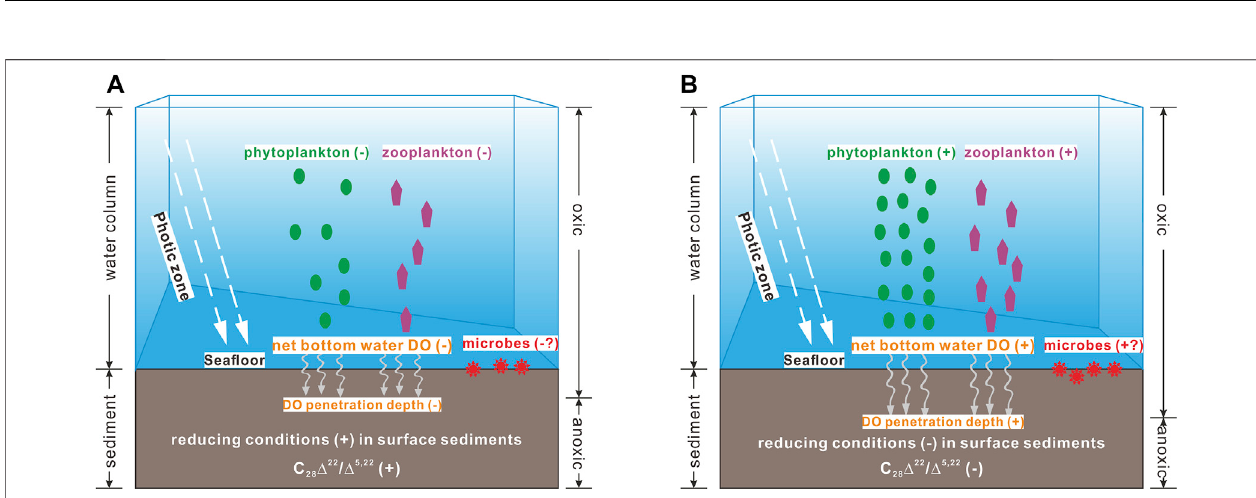
FIGURE9| SchematicdiagramofthebiogeochemicalmechanismofphotosyntheticproductionindeterminingbottomwaterDOvariationsinsurfacesedimentsin the shallow, clear YDU area, showing (A) decreased bottom water oxygenation ( − ) and more reducing surface sediment (+) indicated by higher C 28 Δ 22 / Δ 5,22 ratio (+) in responsetolowerPPindicatedbylessabundant (cid:4) sterols( − ),and (B) increasedbottomwateroxygenation(+)andlessreducingsurfacesediment( − )indicatedbylower C 28 Δ 22 / Δ 5,22 ratio( − )inresponsetohigher PPindicatedbymoreabundant (cid:4) sterols (+).Here,anaerobicconversion ofC 28 Δ 5,22 issettingtooccurprincipallyinthe oxic-anoxic transitionzoneinmicrobiologicallyactivesurfacesediment,andthus,theC 28 Δ 22 / Δ 5,22 ratioateachsedimentaryintervalismainlygovernedbybottomwater DO level at the time of deposition. For detail in, e.g., fi gure (B) , higher abundances of phytoplankton can fuel more abundant zooplankton ( Figure 5 ) in the total photic water column; however, higher amounts of phytoplankton (and phytoplankton-dependent zooplankton) derived relatively labile organic matter may not always lead to increased microbial biomass (i.e., at sites S201 and S401; Figure 5 ). Regardless of certain degree of DO consumption by zooplankton respiration and microbial remineralization,thedominantroleofDOproductionbyphytoplanktonphotosynthesisinthephoticzone( Figure8 )maystillleadtohigherextentofnetbottomwaterDO penetrating into surface sediment, resulting in less reducing condition and thus lower sedimentary C 28 Δ 22 / Δ 5,22 ratio.